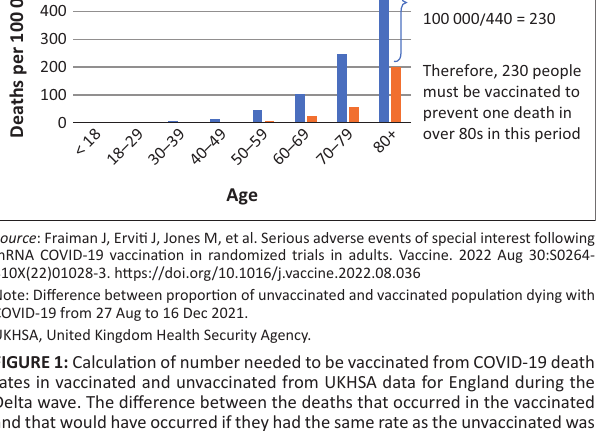
FIGURE 1: Calculation of number needed to be vaccinated from COVID-19 death rates in vaccinated and unvaccinated from UKHSA data for England during the Delta wave. The difference between the deaths that occurred in the vaccinated and that would have occurred if they had the same rate as the unvaccinated was used to calculate the number of people who would need to be vaccinated to prevent a single